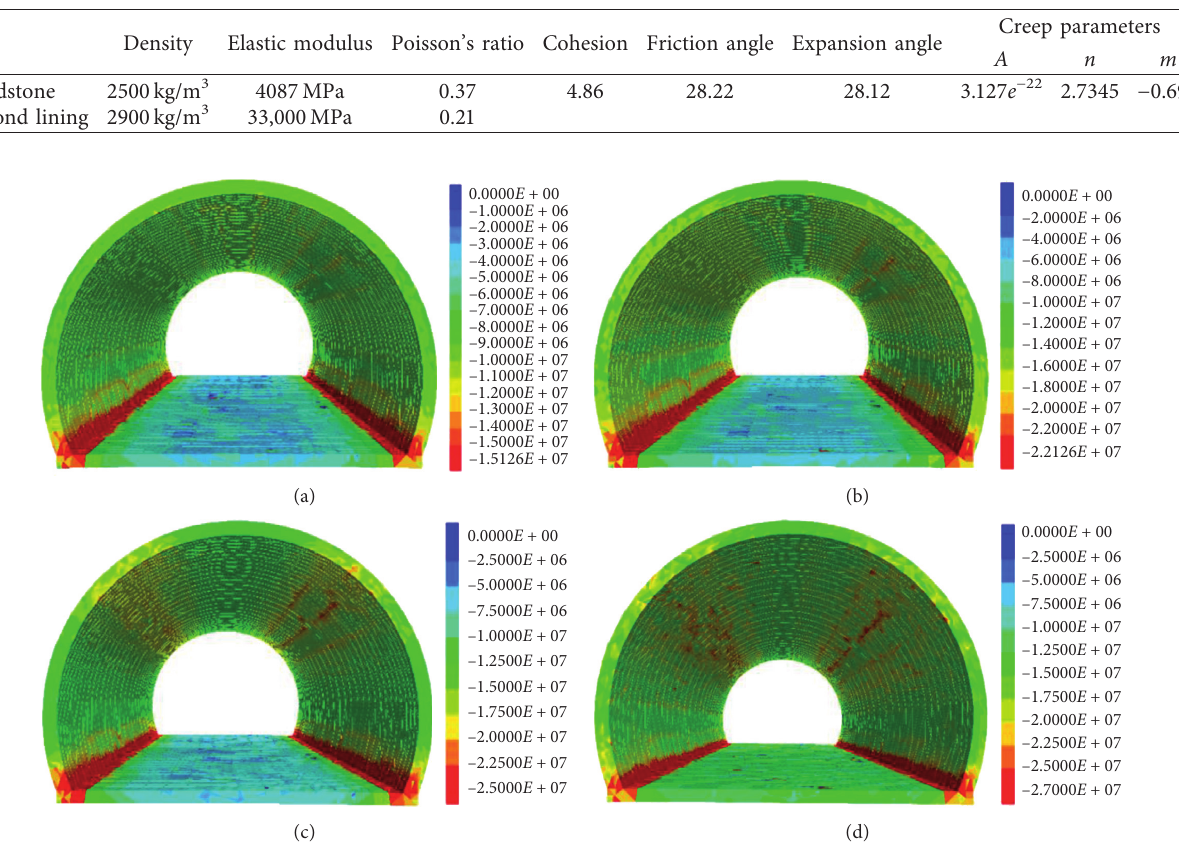
Figure 8: Stresscharacteristicsoftunnelsecondaryliningunderdifferenttimeconditions.(a)Maximumstressoftunnelbeforecreep.(b)Maximum stress state after creep 0.5 years. (c) Maximum stress state after creep 1 years. (d) Maximum stress state after creep 2